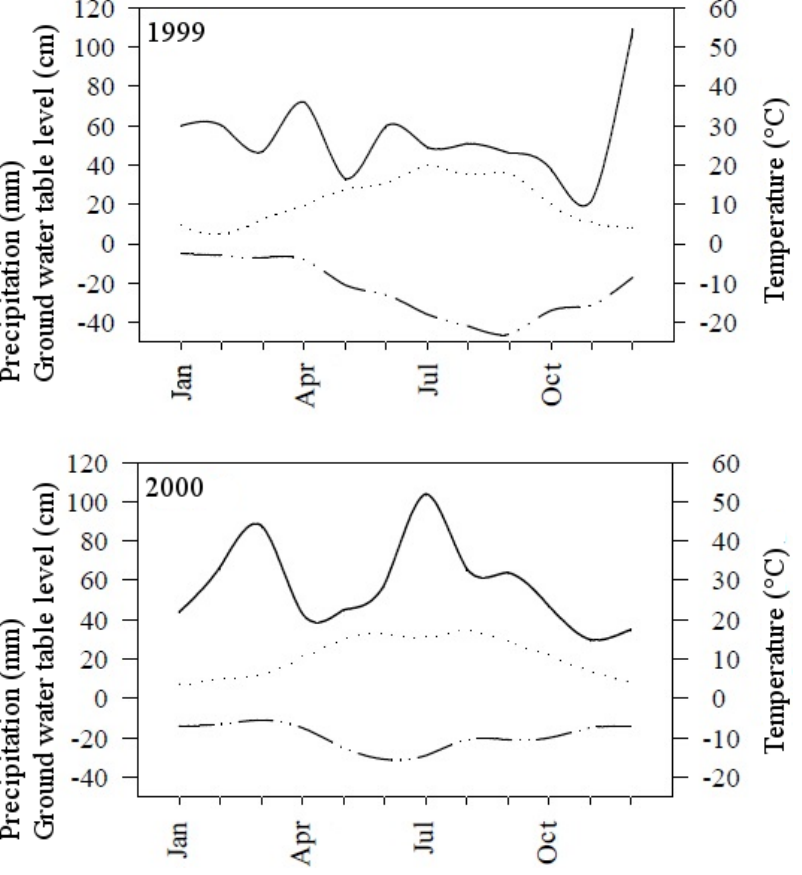
Figure 1. Temperature (dotted line, right y-axis), precipitation (solid line, left y-axis), and water table level (broken line, left y-axis) averaged across the total pasture area for the first year (1999, above) and second year (2000, below) of the